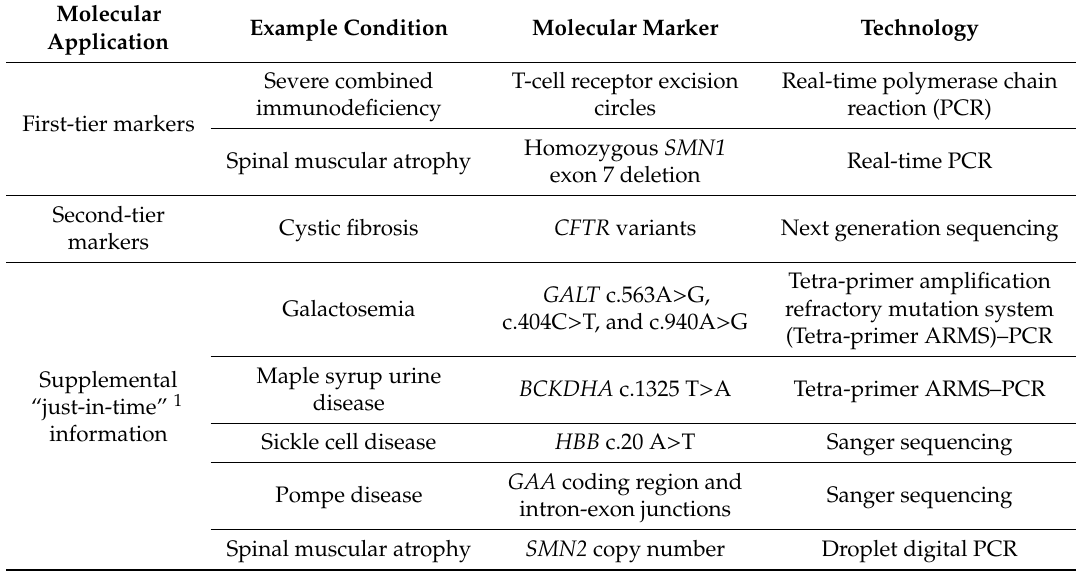
Table 1. Molecular technology applications in Wisconsin routine newborn